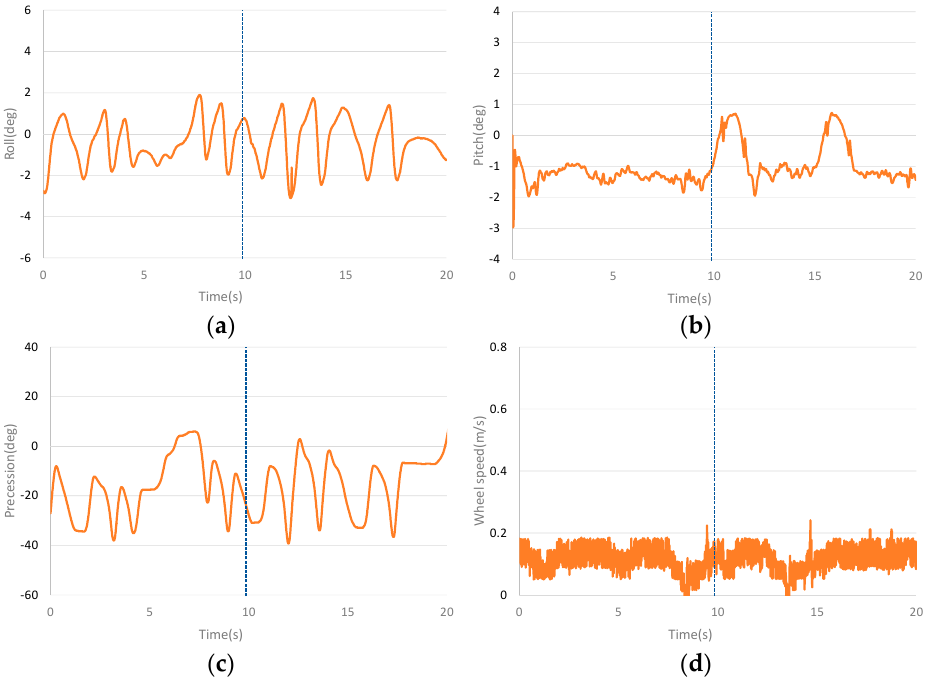
Figure 9. Dynamic balance curves after placing a mass block in middle. ( a ) The roll angle curve of placing material block in the middle. ( b ) The pitch angle curve of placing material block in the middle. ( c ) The precession angle curve of placing material block in the middle. ( d ) The speed curve of placing material block in the middle.